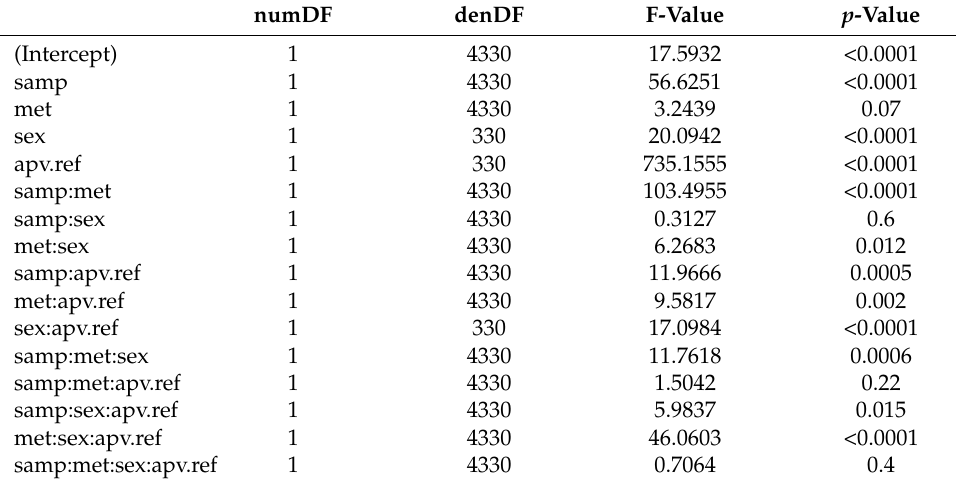
Table 3. Analysis of Variance of the Linear Mixed Effects model for differences (D) between estimates and references values of Age at Peak Velocity (APV) with effects of sample (samp, 1–7), sex (sex, males, females), estimation method (met, FPCA, SITAR), and reference APV (apv.ref, age in years), including all